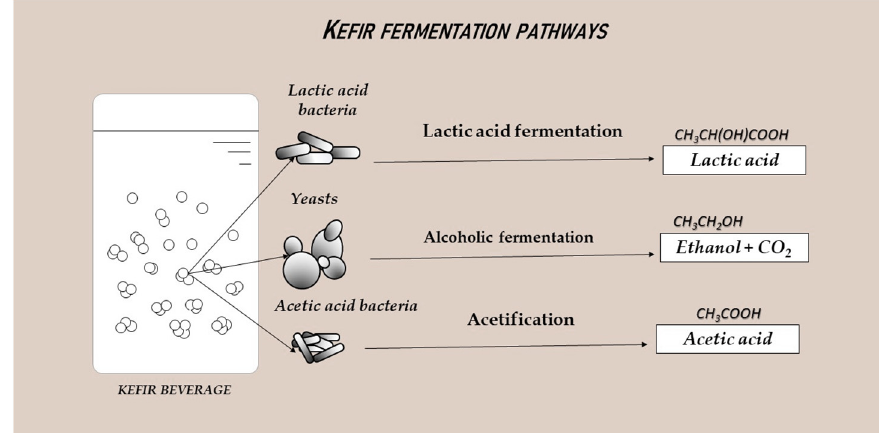
Figure 1. Different fermentation pathways following from the main microbial species (lactic acid bacteria, yeasts, and acetic acid bacteria) contained in kefir and kefir grains.